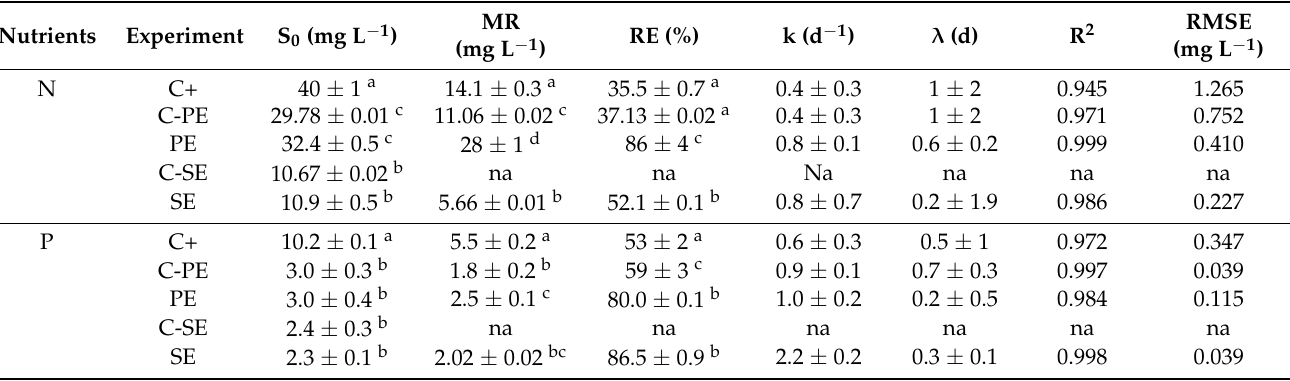
Table 4. Nitrogen and phosphorus initial concentration, removal parameters, and kinetic parameters correspondent to the modified Gompertz model obtained for each